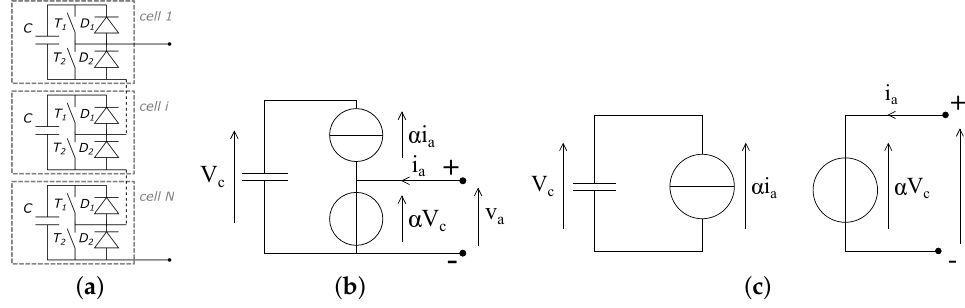
Figure 4. Models for simulation of MMC in normal operation. ( a ) Real cluster. ( b ) Averaged model of the cluster. ( c ) Averaged model of the cluster divided into two parts. Table 3. Comparison between the model with discrete devices and the averaged model. Modelling